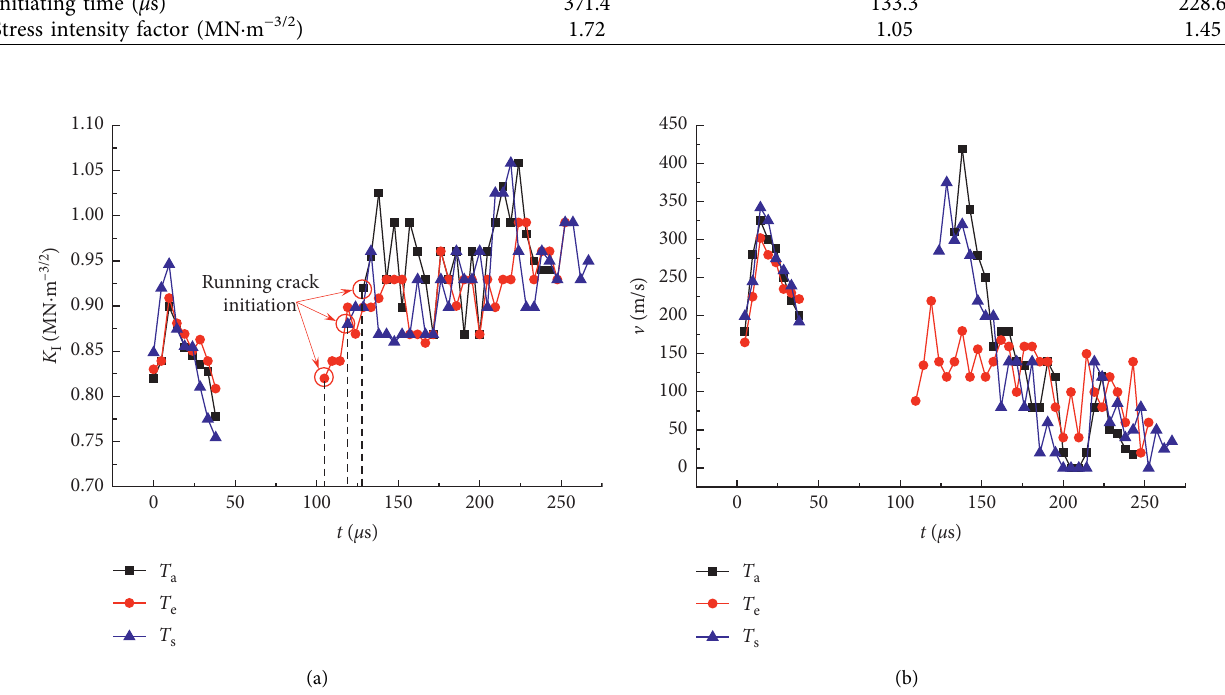
Figure 8: Changing curves of dynamic mechanical parameters of the running crack with time in the rectangular defect group. (a) K (b) v − t .